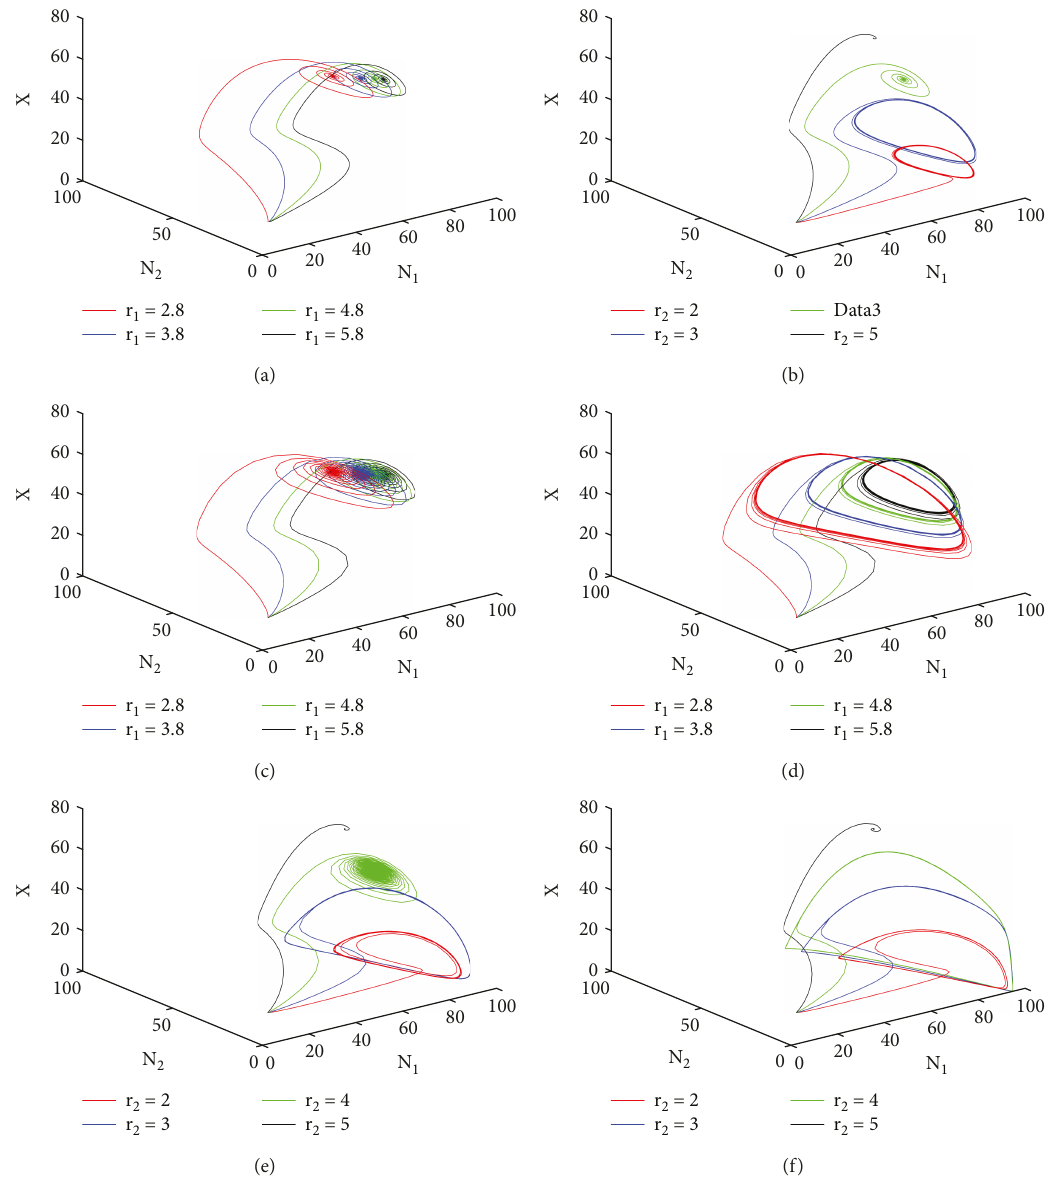
ff erent r 1 at